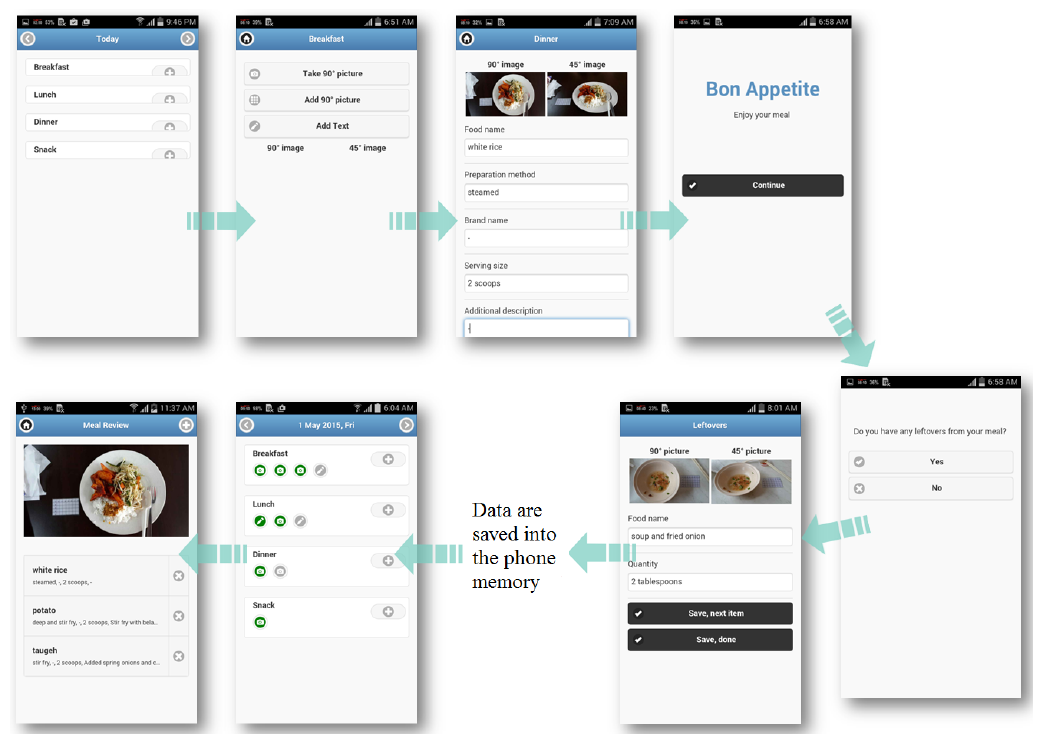
Figure 1. Illustration of food recording process using the food app.